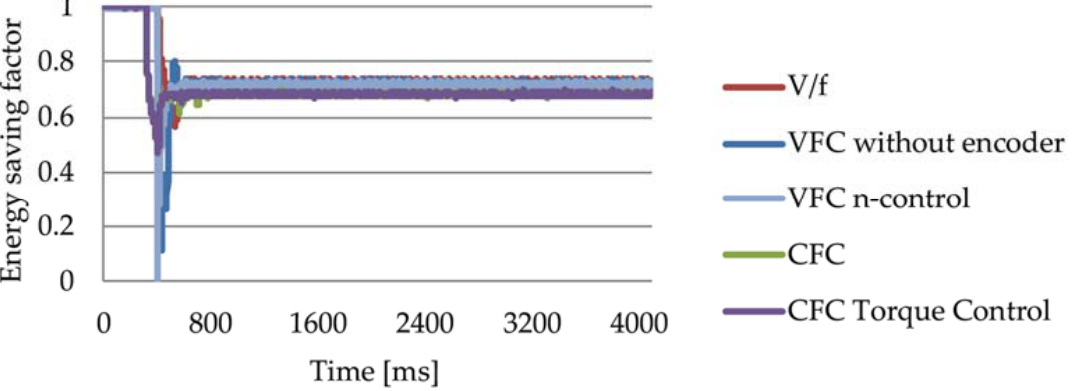
Table 10. Characteristics of the energy efficiency E SF in the steady state (without an external load).